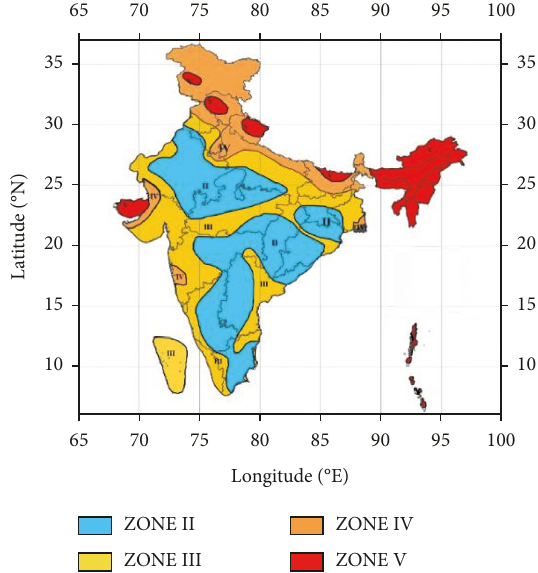
Figure 11: Seismological map of India